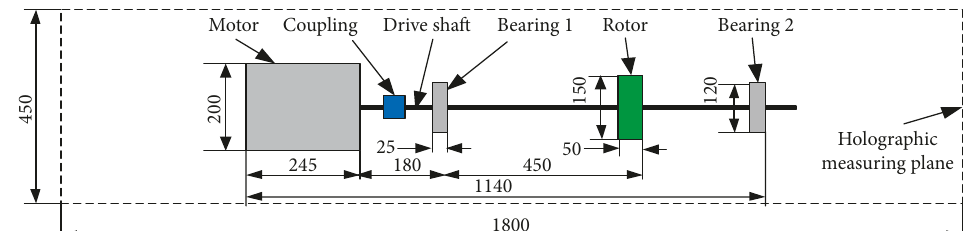
Figure 3: Layout diagram of the motor-bearing